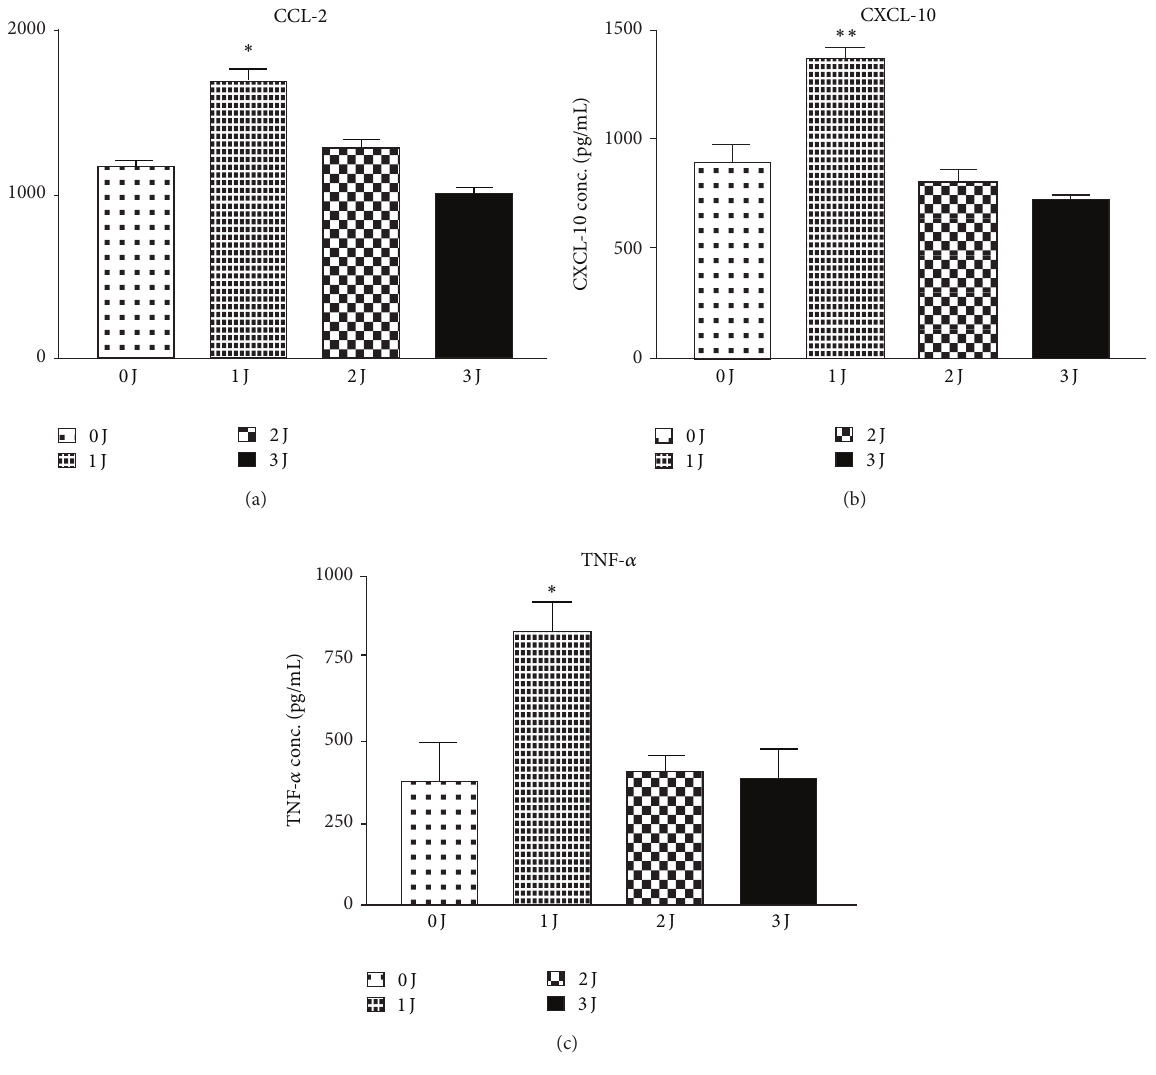
Figure 3: LLLT-induced M1-related CCL2 and CXCL10 protein expression in monocytes using ELISA assay. oneJ/cm 2 of 660 nm LLLT significantly induced CCL2 (a), CXCL10 (b), and TNF- 𝛼 (c) production in THP-1 cells, whereas either 2J/cm 2 or 3 J/cm 2 did not. ∗ 𝑃 < 0.05 ; ∗∗ 𝑃 < 0.01 ; and ∗∗∗ 𝑃 < 0.001 between control and LLLT